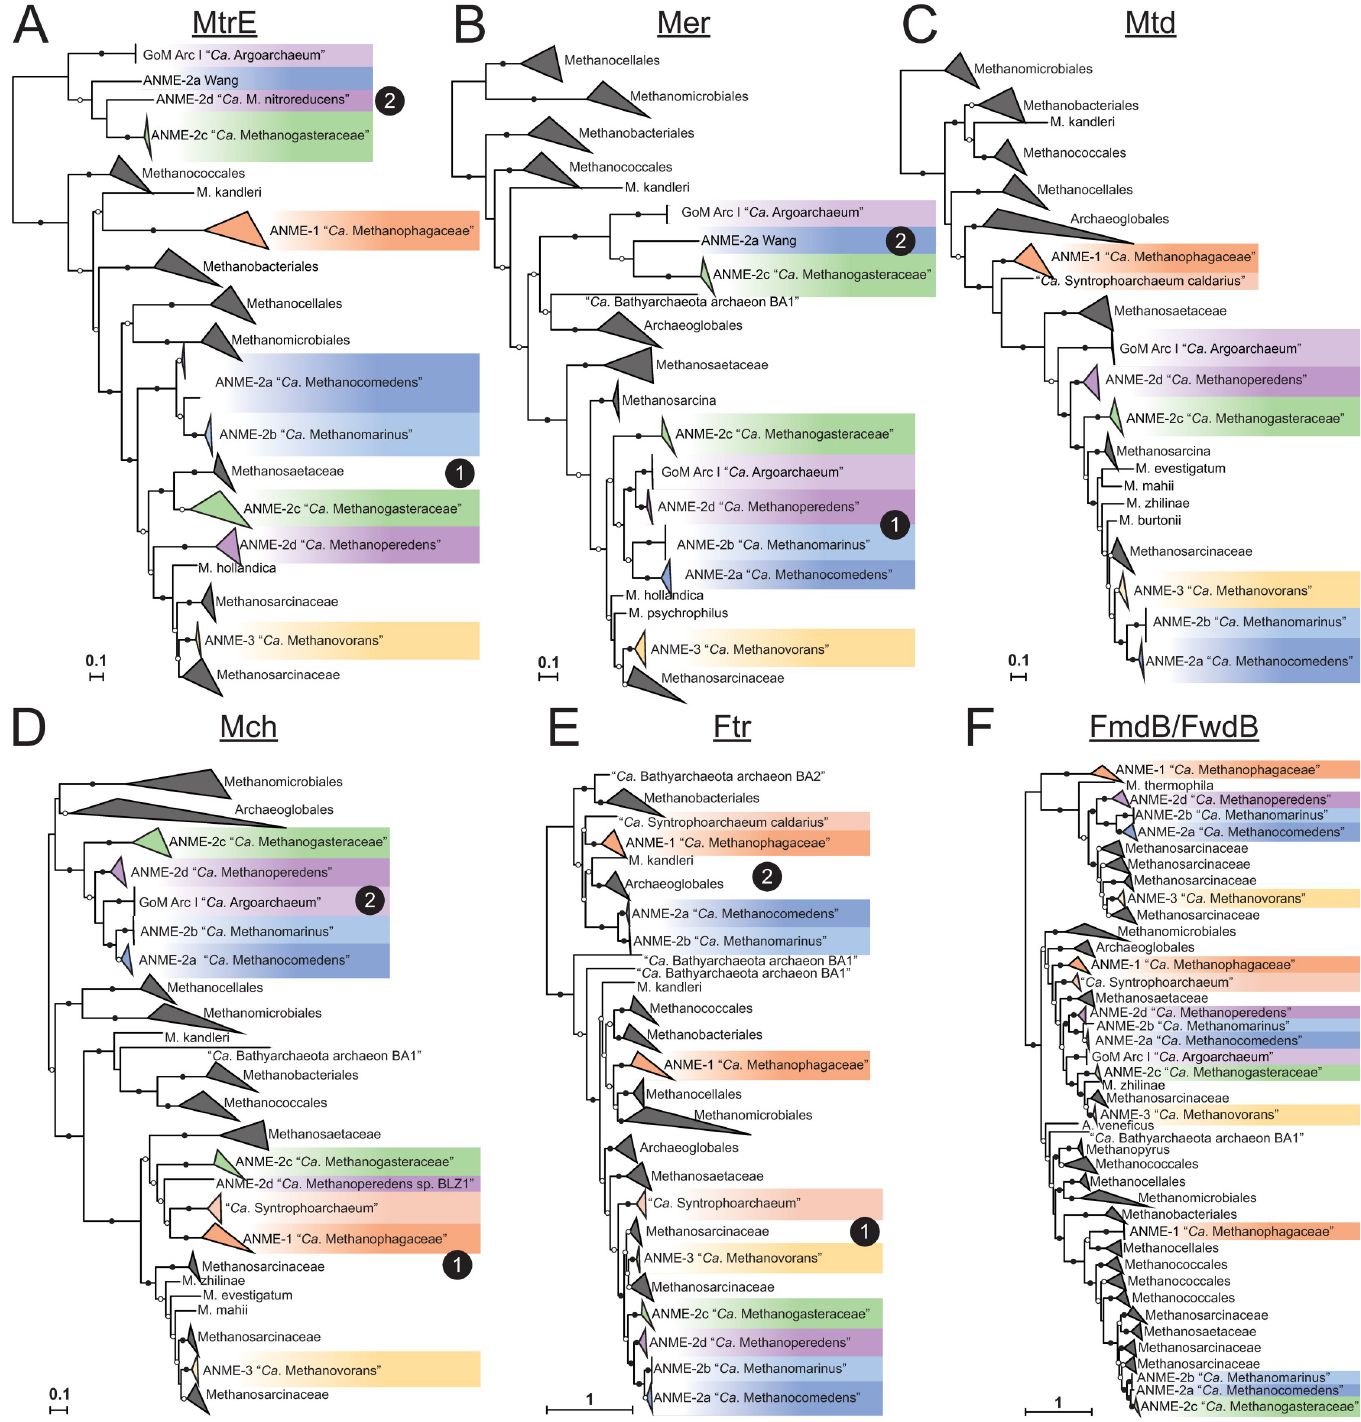
Fig 4. Phylogeny of enzymes in the methanogenesis pathway. Phylogenetic trees constructed from protein sequences of enzymes involved in the methanogenesis pathway in ANME and related archaea. Mcr phylogeny is presented in Fig 1 . Numbers next to clades indicate whether the cluster is closely related to those found in Methanosarcinaceae [1] or are distantly related homologs [2], matching labels in Fig 3 . ( A ) MtrE, N 5 -methyl-H 4 MPT:coenzyme M methyltransferase subunit E; ( B ) Mer, methylene-H 4 MPT reductase; ( C ) Mtd, F 420 -dependent methylene-H 4 MPT dehydrogenase; ( D ) Mch, N 5 ,N 10 -methenyl-H 4 MPT cyclohydrolase; ( E ) Ftr, formylmethanofuran-H 4 MPT formyltransferase; ( F ) FmdB/FwdB, formyl-methanofuran dehydrogenase subunit B, molybdenum/tungsten variety, respectively. Branch support values of 100% are labeled with closed circles, > 50% with open circles. Tree scales represent substitutions per site. Tree construction parameters are found in the Materials and methods section. Alignments and tree files can be found in S1 Data. ANME, anaerobic methanotrophic; Mcr, methyl-coenzyme M reductase. https://doi.org/10.1371/journal.pbio.3001508.g004 PLOS Biology | https://doi.org/10.1371/journal.pbio.3001508 January5, 2022 10 /